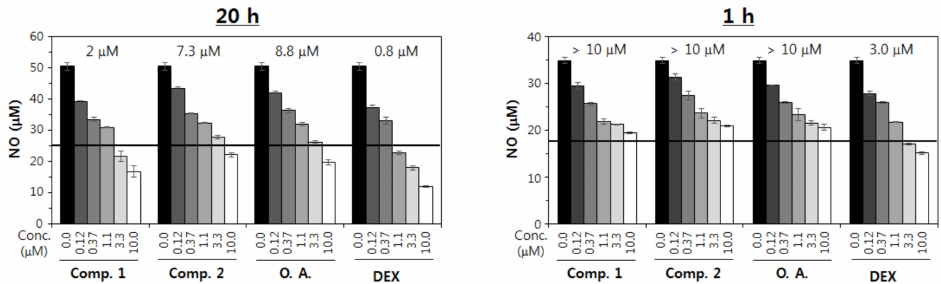
Figure 5. Inhibition of the activation of the RAW 264.7 cell line by the active compounds 1 (Comp. 1 ) and 2 (Comp. 2 ), in vitro. Cells were treated with di ff erent concentrations of compounds 1 – 2 , oleanolic acid ( O.A. ) and dexamethasone ( DEX ), separately. Nitrite oxide concentrations in the culture supernatants were determined using a Griess reagent assay. Dexamethasone was used as the positive